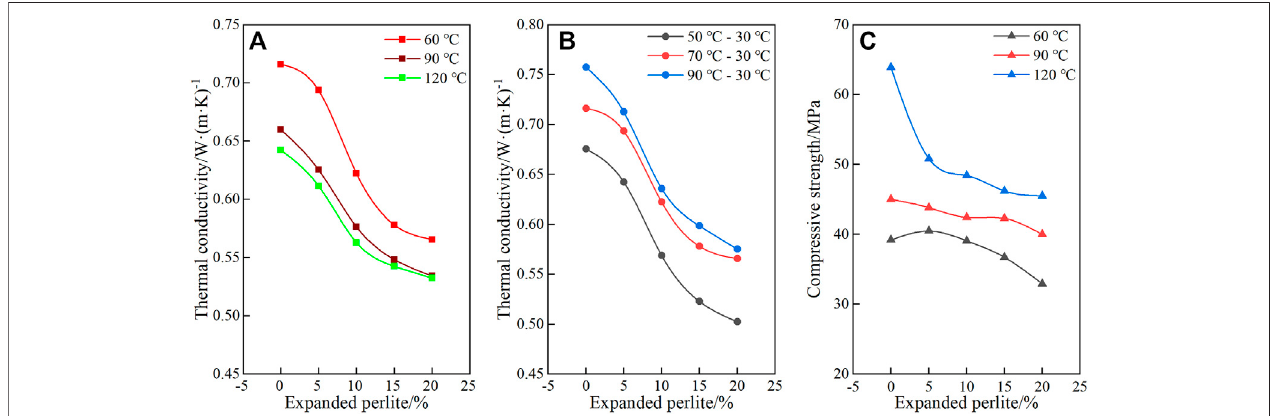
FIGURE 10 | Test results of thermal conductivity and compressive strength of thermal insulation cement with expanded perlite under different conditions. (A) Test resultsofthermalconductivityatdifferentcuringtemperatures.Thetesttemperaturecombinationis70 – 30 ° C. (B) Testresultsofthermalconductivityatdifferenthotplate temperatures. The curing temperature is 60 ° C. (C) Test results of compressive strength at different curing